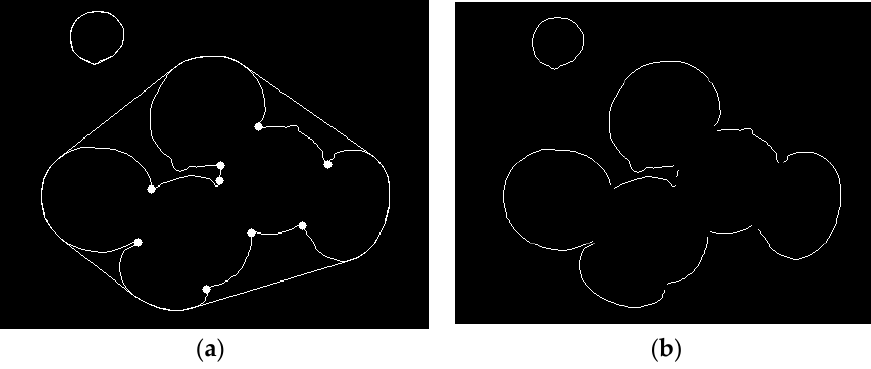
Figure 8. Contour segmentation of Agaricus bisporus. ( a ) Split point; ( b ) split contour segment.